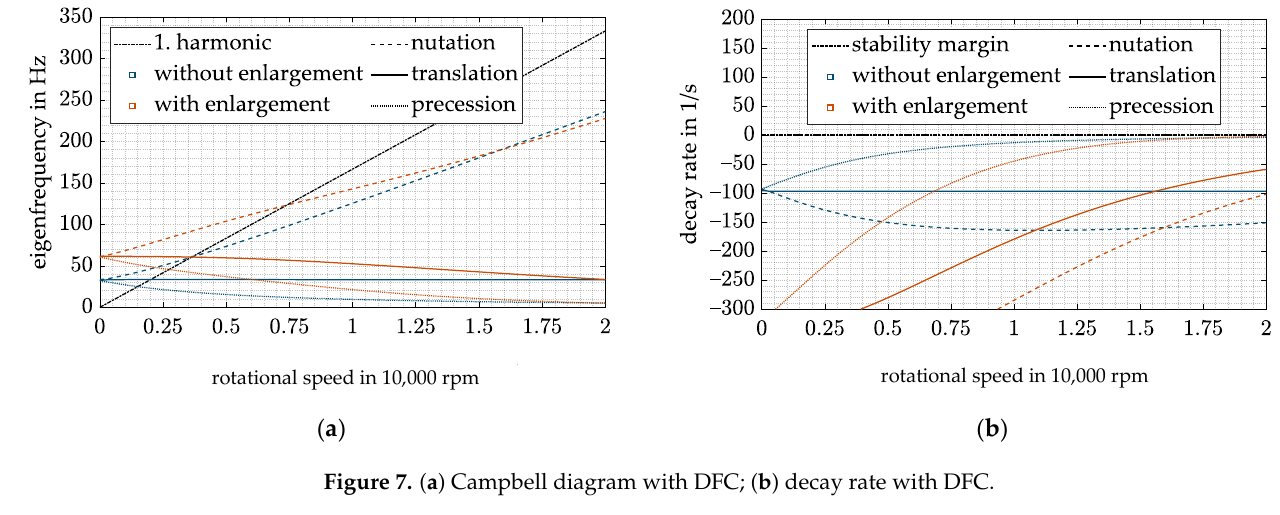
Figure 4. k i and k s against the rotational speed.